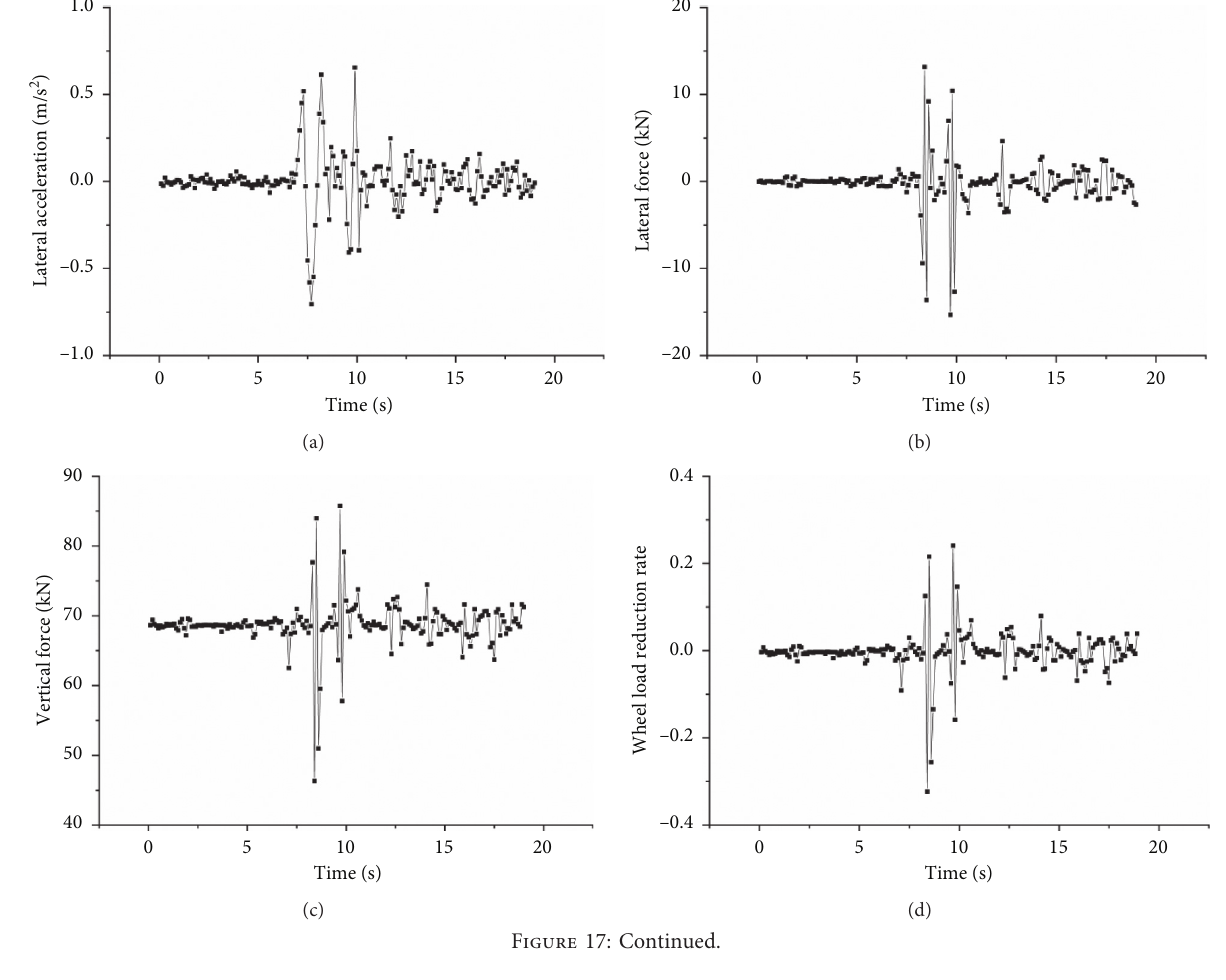
Figure 16: Boundary equivalent loads of the Qian’an wave. (a) Normal equivalent load F F ( t ) -time BT